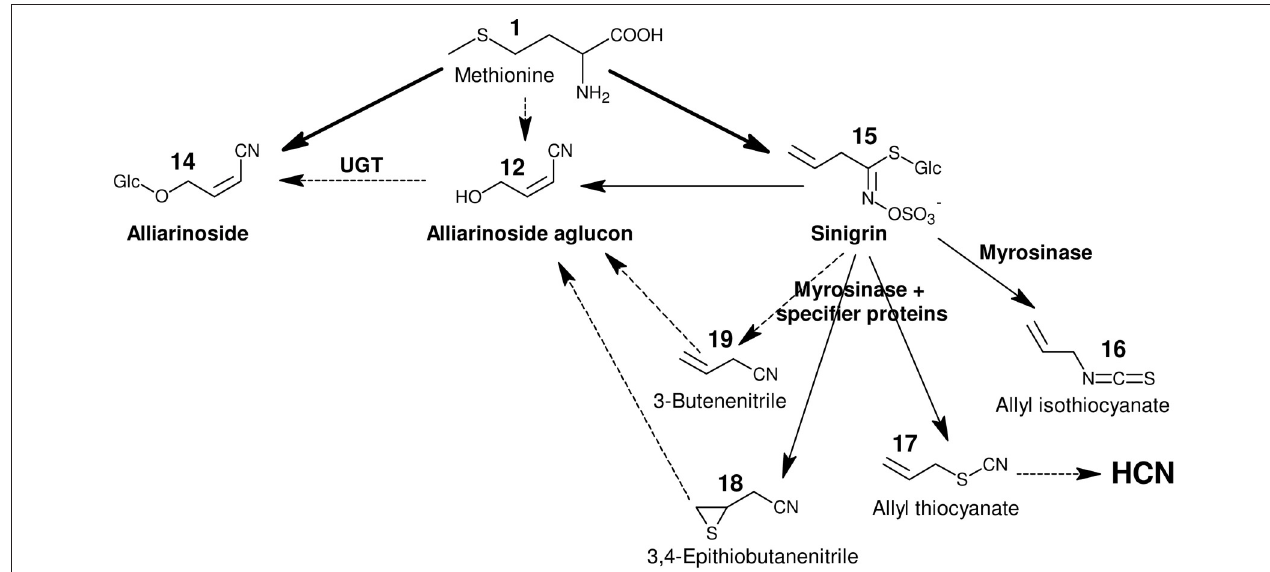
FIGURE 6 | Proposed biosynthetic origin of alliarinoside and HCN in A. petiolata . All illustrated metabolites were detected in either homogenate or microsomes prepared from A. petiolata leaves. Bold arrows signify biosynthesis demonstrated in planta , plain solid arrows signify reactions demonstrated in vitro , and dotted arrows indicate proposed reactions based on these reactions and other results obtained in the current study. The alliarinoside aglucon (12) is presumed to be produced by only one of the proposed routes via either 3,4-epithiobutanenitrile (18) or 3-butenenitrile (19). For further details on tested reactions, occurrence of compounds and abbreviations refer to Figures 2 – 5 regarding alliarinoside and Figures 7 , 8 regarding